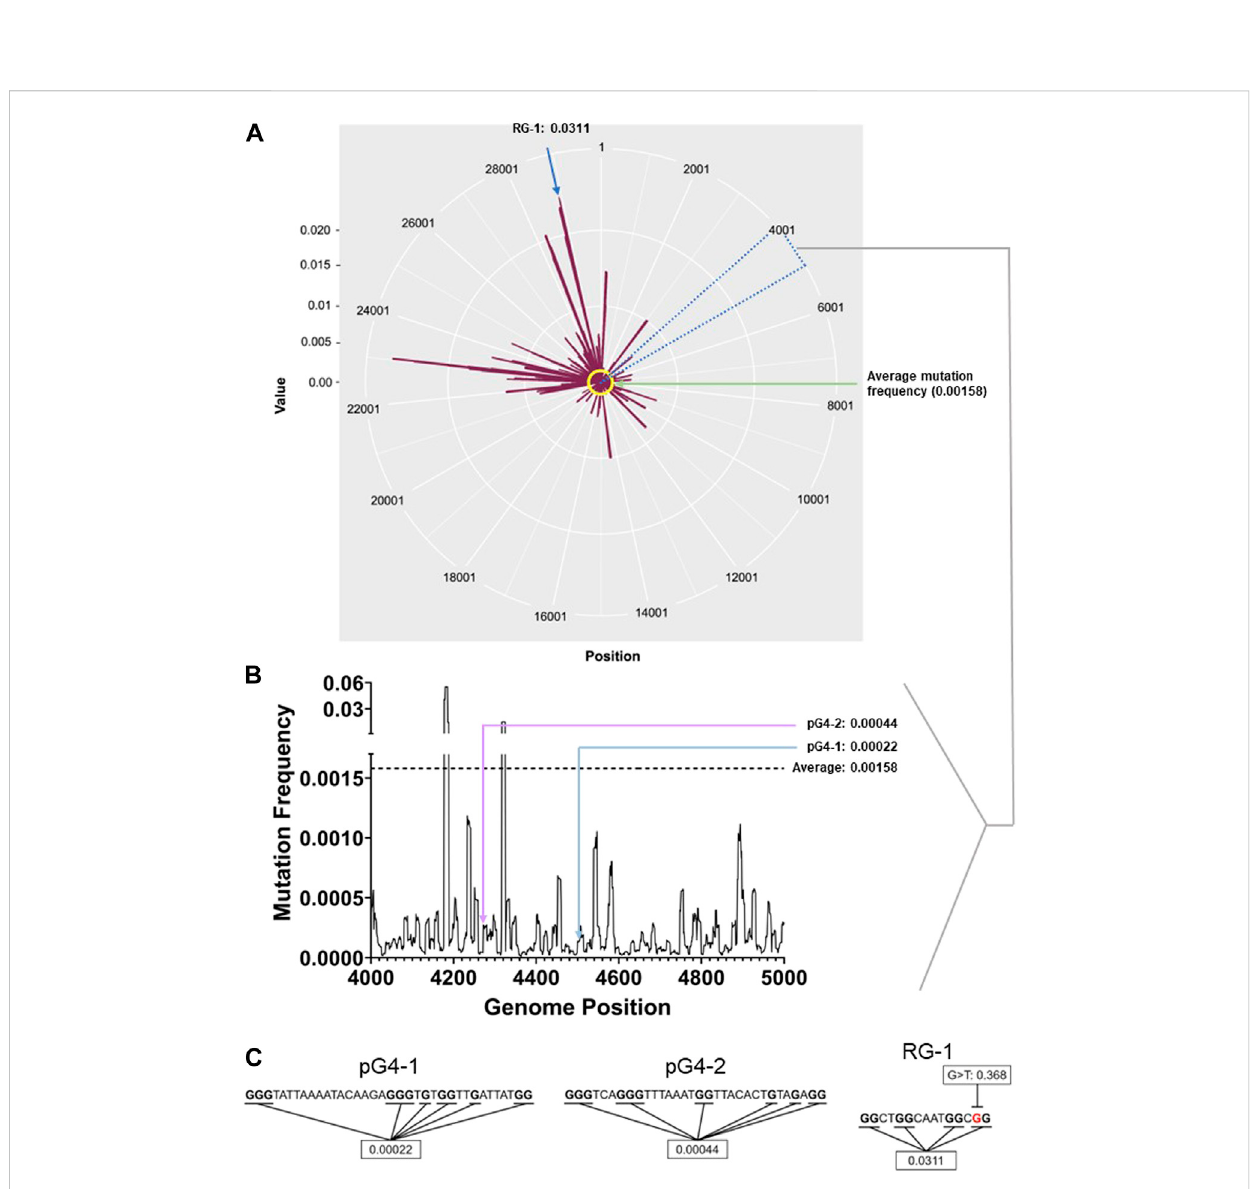
FIGURE 1 pG4 motifs in the SARS-CoV-2 genome are conserved. (A) Mutation frequency (number of sequenced genomes with mutation at a given base position/total number of sequenced genomes) of each nucleotide of the SARS-CoV-2 genome plotted against their respective genomic positions. The average mutation frequency is marked in yellow. Location of RG-1 has been denoted. The circos plot was prepared using ggplot2 package in R. (B) Mutation frequency within the 4,000-5,000 bp positions to clearly denote the mutation frequency of pG4-1 and pG4-2. The line histogram